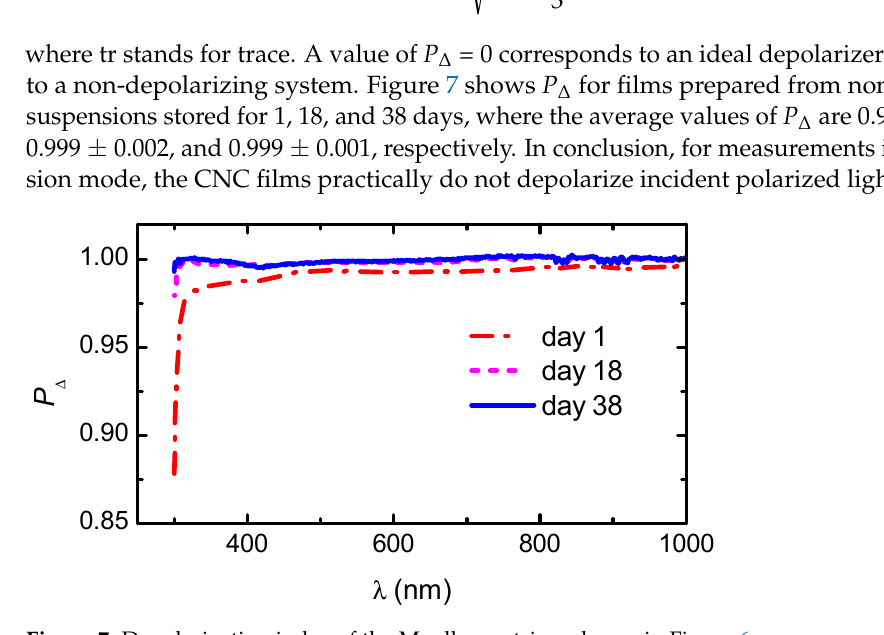
Figure 7. Depolarization index of the Mueller matrices shown in Figure 6.